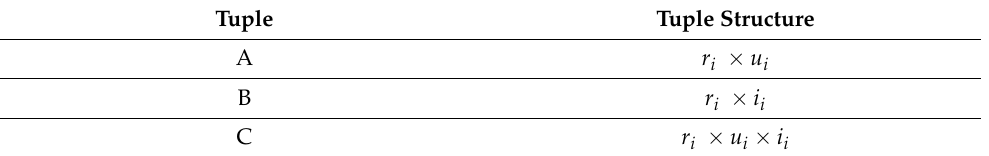
Table 2. Structure of the